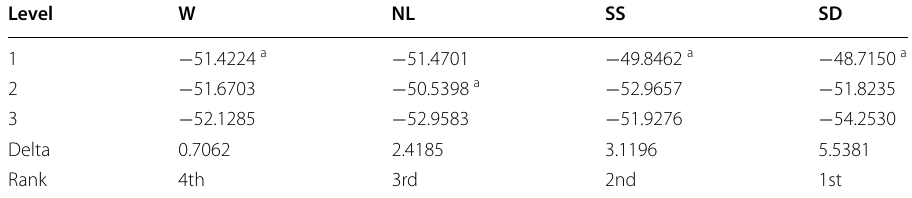
Key: a Denotes optimal